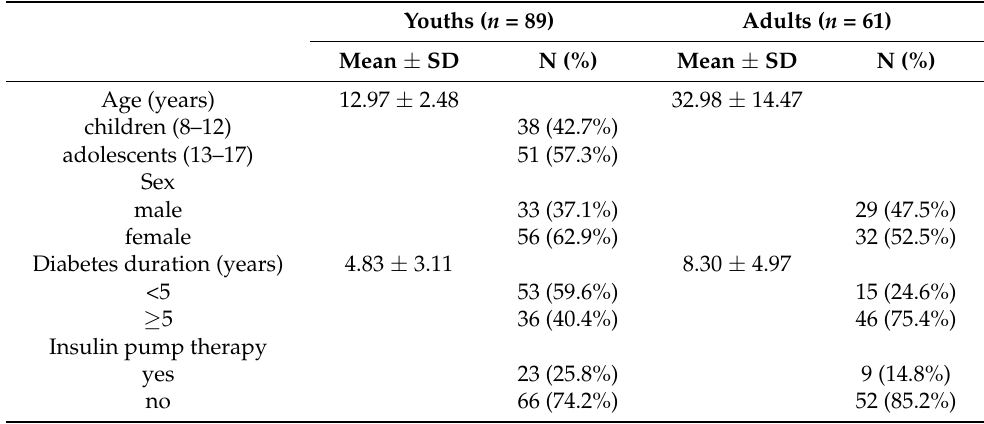
Table 1. Demographics and type 1 diabetes (T1D)-related characteristics of youths ( n = 89) and adults ( n =